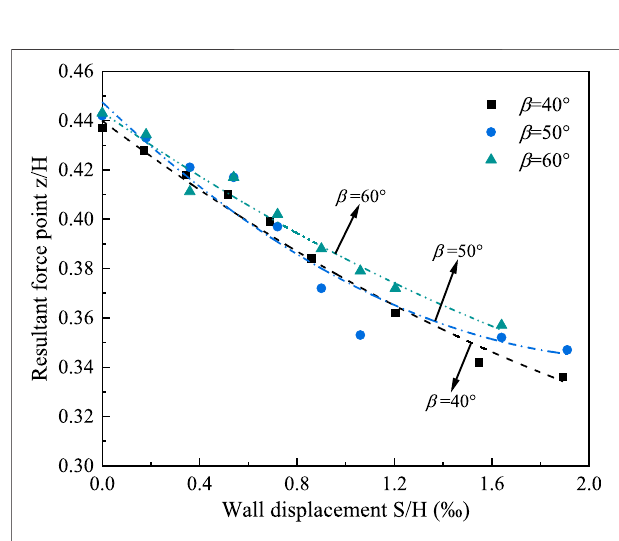
FIGURE 10 | Change of height of Resultant force point with wall displacement in RB mode.